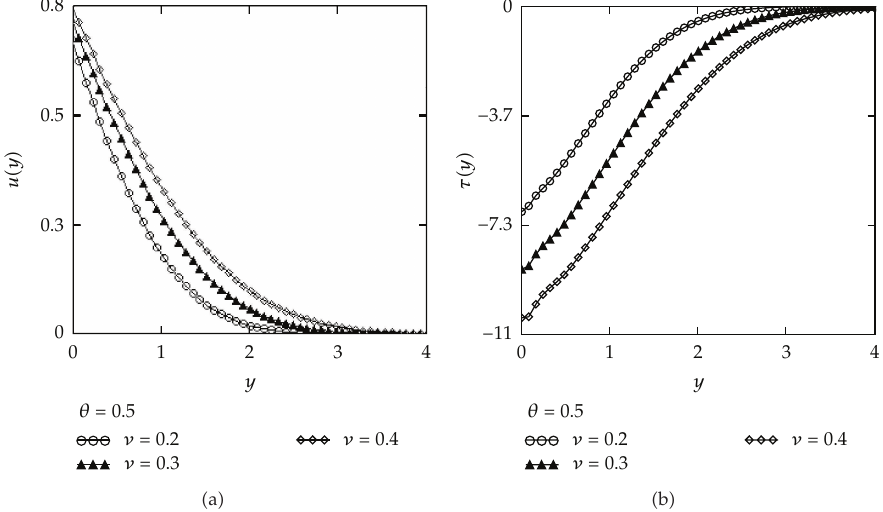
Figure 9: Profiles of the velocity field u (cid:4) y,t (cid:5) and the shear stress τ (cid:4) y,t (cid:5) for fractional Maxwell fluid given by (cid:4) 4.7 (cid:5) and (cid:4) 4.15 (cid:5) , for U (cid:9) 1, y (cid:9) 1, ρ (cid:9) 87 . 071, λ (cid:9) 1 . 5, α (cid:9) 0 . 2, θ (cid:9) 0 . 5, t (cid:9) 5s, and di ff erent values of ν